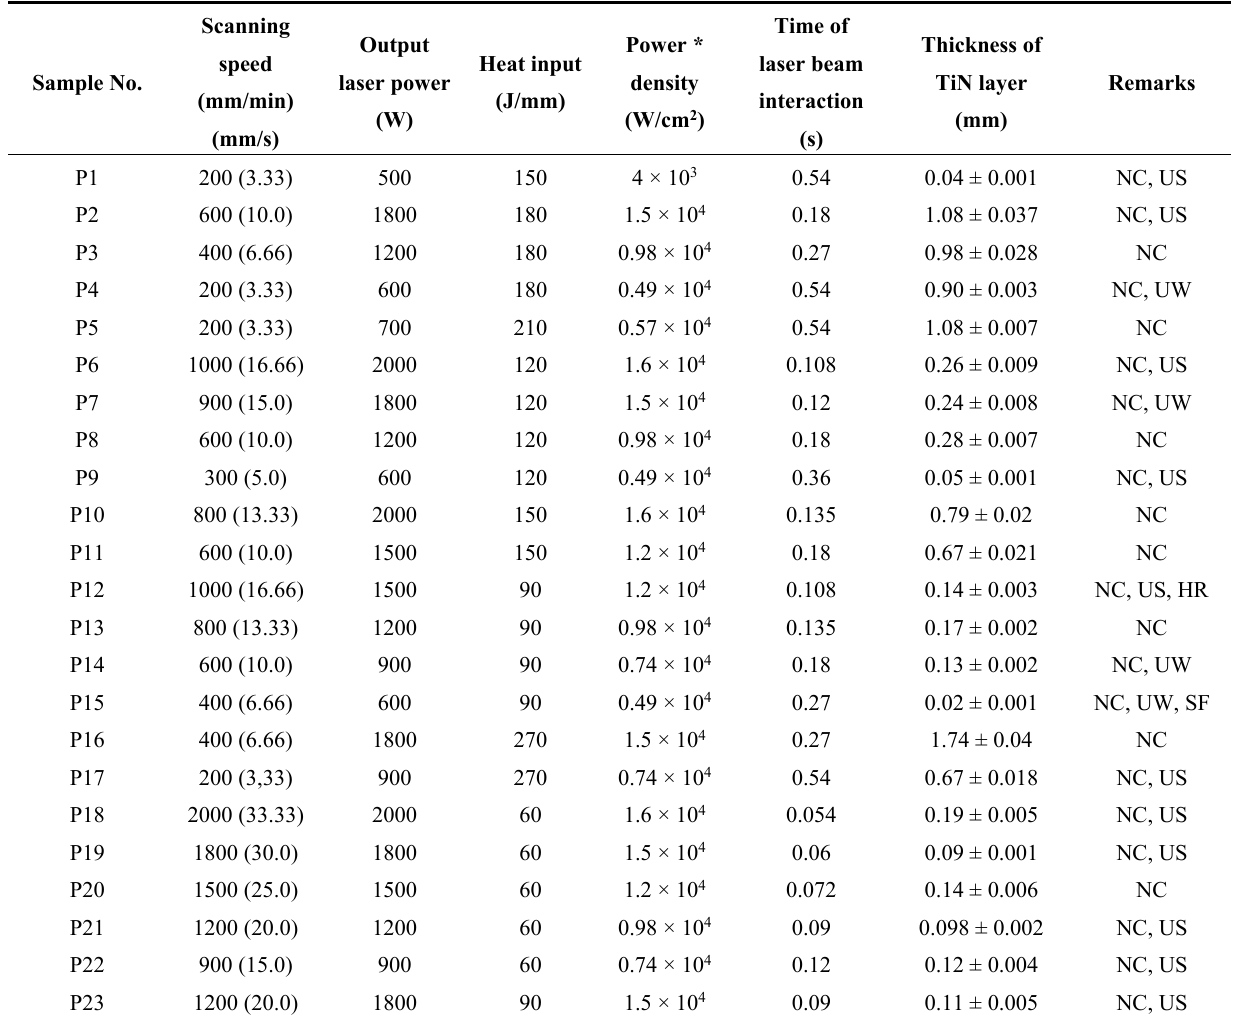
Table 2. Parameters of laser gas nitriding of titanium alloy Ti6Al4V specimens 3.0 mm thick by the high power direct diode laser ROFIN DL